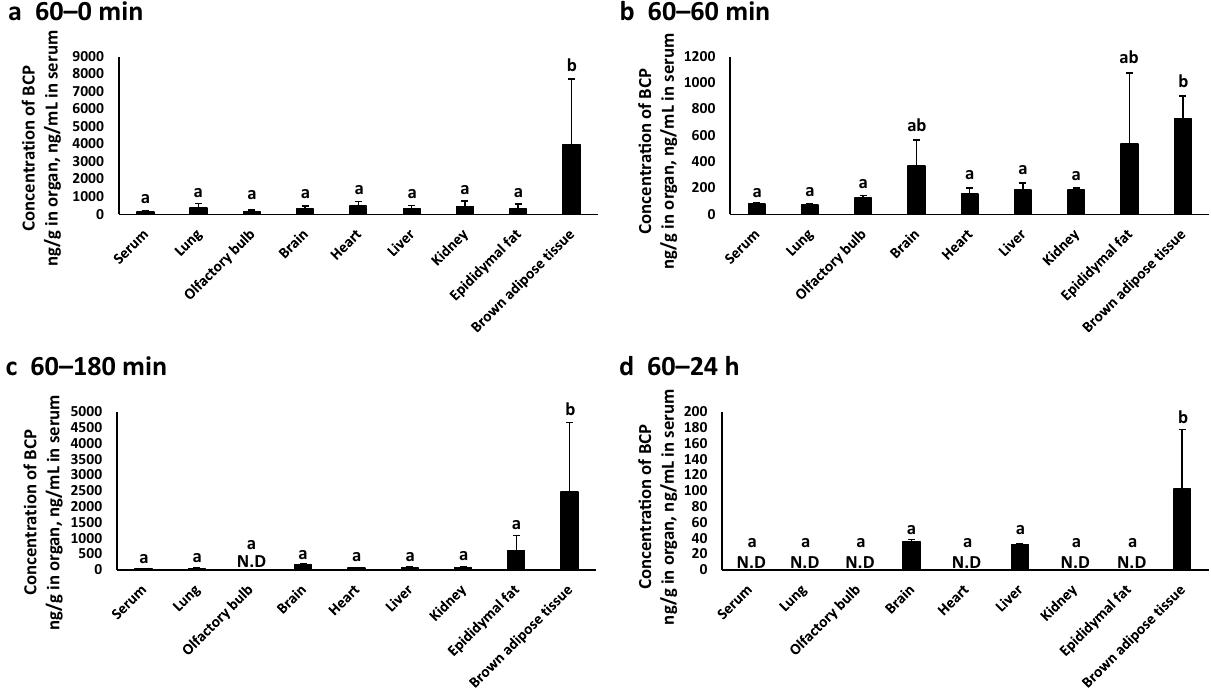
Figure 1. BCP concentrations in mice. (a) 60–0 min group (n = 6), (b) 60–60 min group (n = 6), (c) 60–180 min group (n = 6), (d) 60 min-24 h group (n = 6). Values with different letters are significantly different (p <